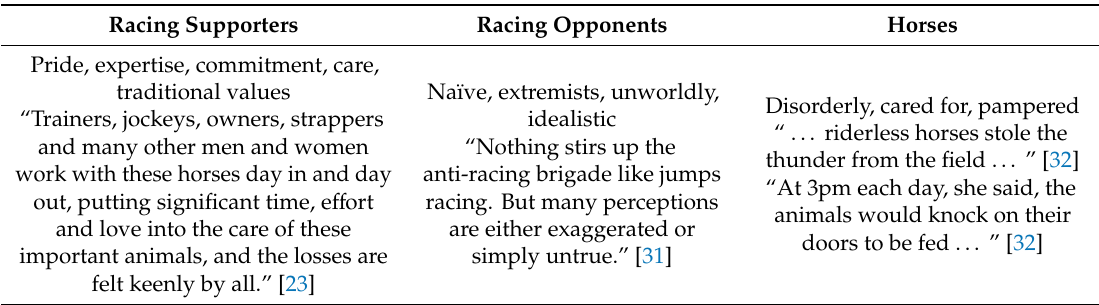
Table 3. Attributes of protagonists in 10 articles supportive of New Zealand jumps racing published between May 2016–August 2018. Racing Supporters